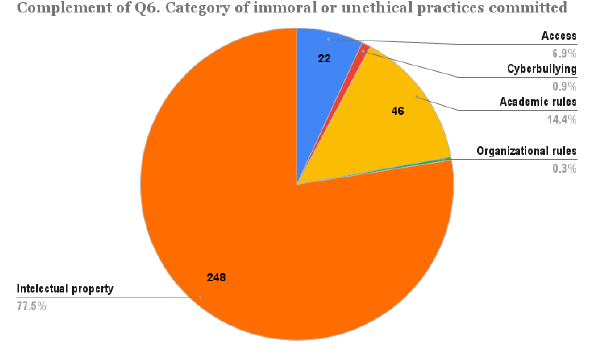
Figure 10. Immoral practice